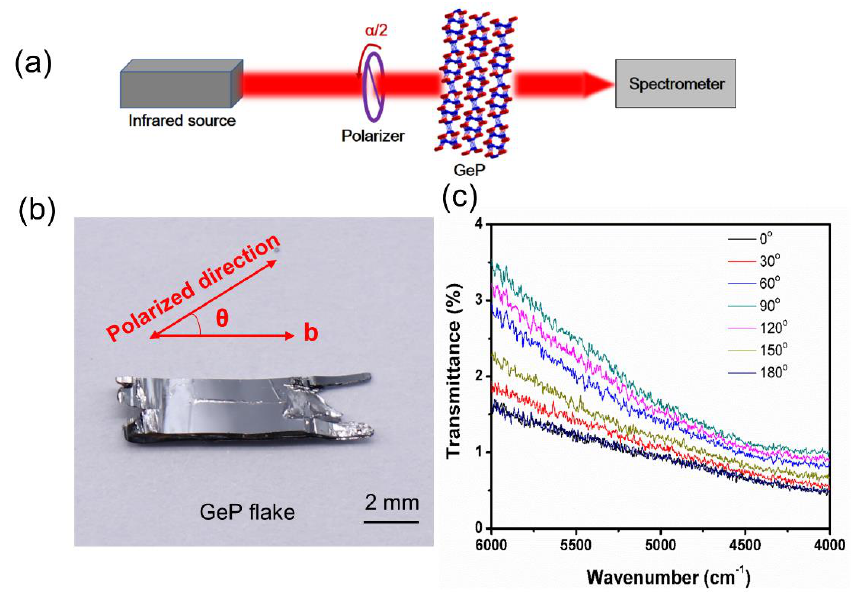
Figure 8. ( a ) Schematic diagram of angle-resolved spectrometer for anisotropic transmission mea- surements. ( b ) Photograph of GeP flake with schematic angle between polarized direction and crystallographic b-axis. ( c ) Infrared transmittance spectra of GeP at different polarization directions.